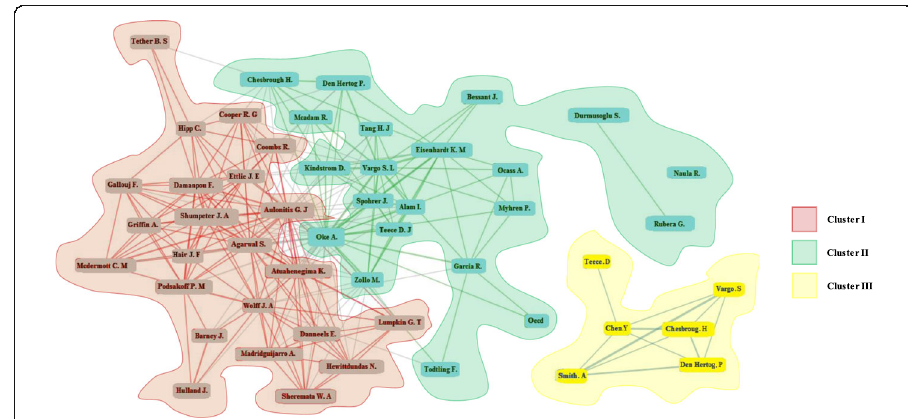
Fig. 7 Relationship network of the co-cited corpus